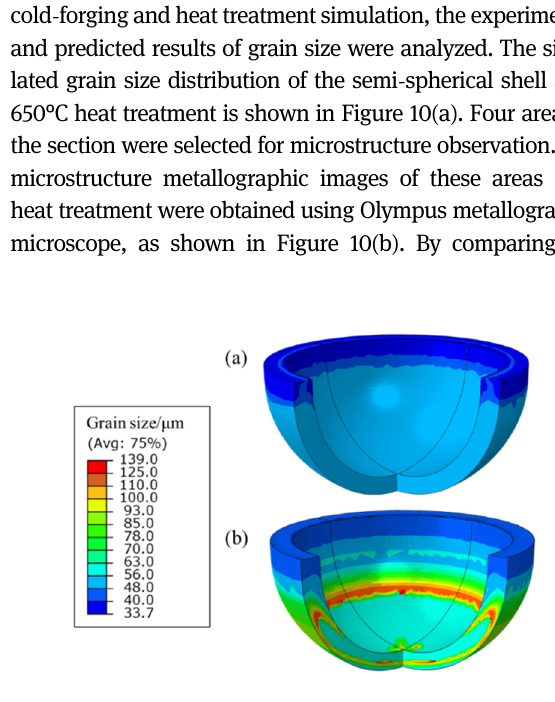
Figure 9: Grain size distributions of the semi - spherical shell at annealing temperatures of ( a ) 650°C and ( b )